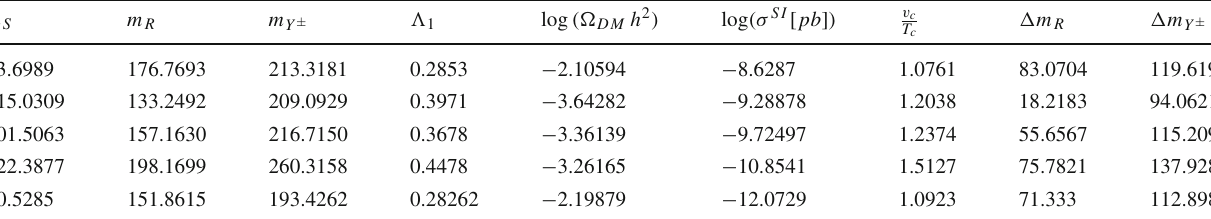
Table 2 A selection of benchmark points for the IDM model which passed all the constraints considered. Masses are in GeV units m S m